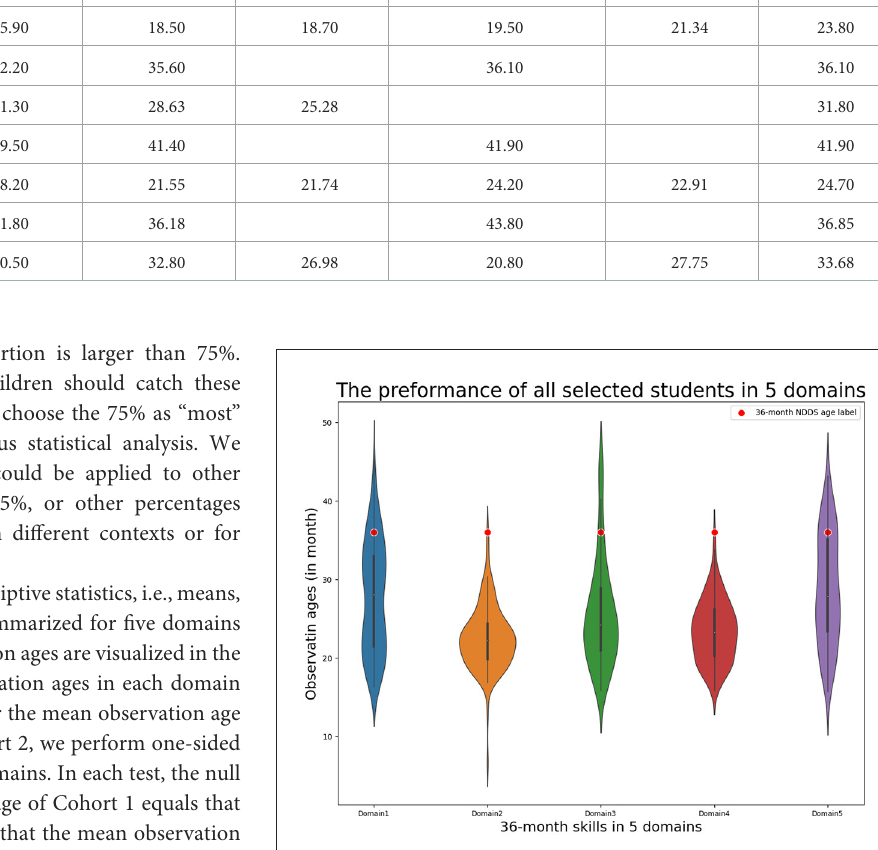
skill that has not been observed until the student left the ECE program. We fit the Cox Proportional-Hazards Model to our dataset and plot the predicted survival curves for two cohorts on each